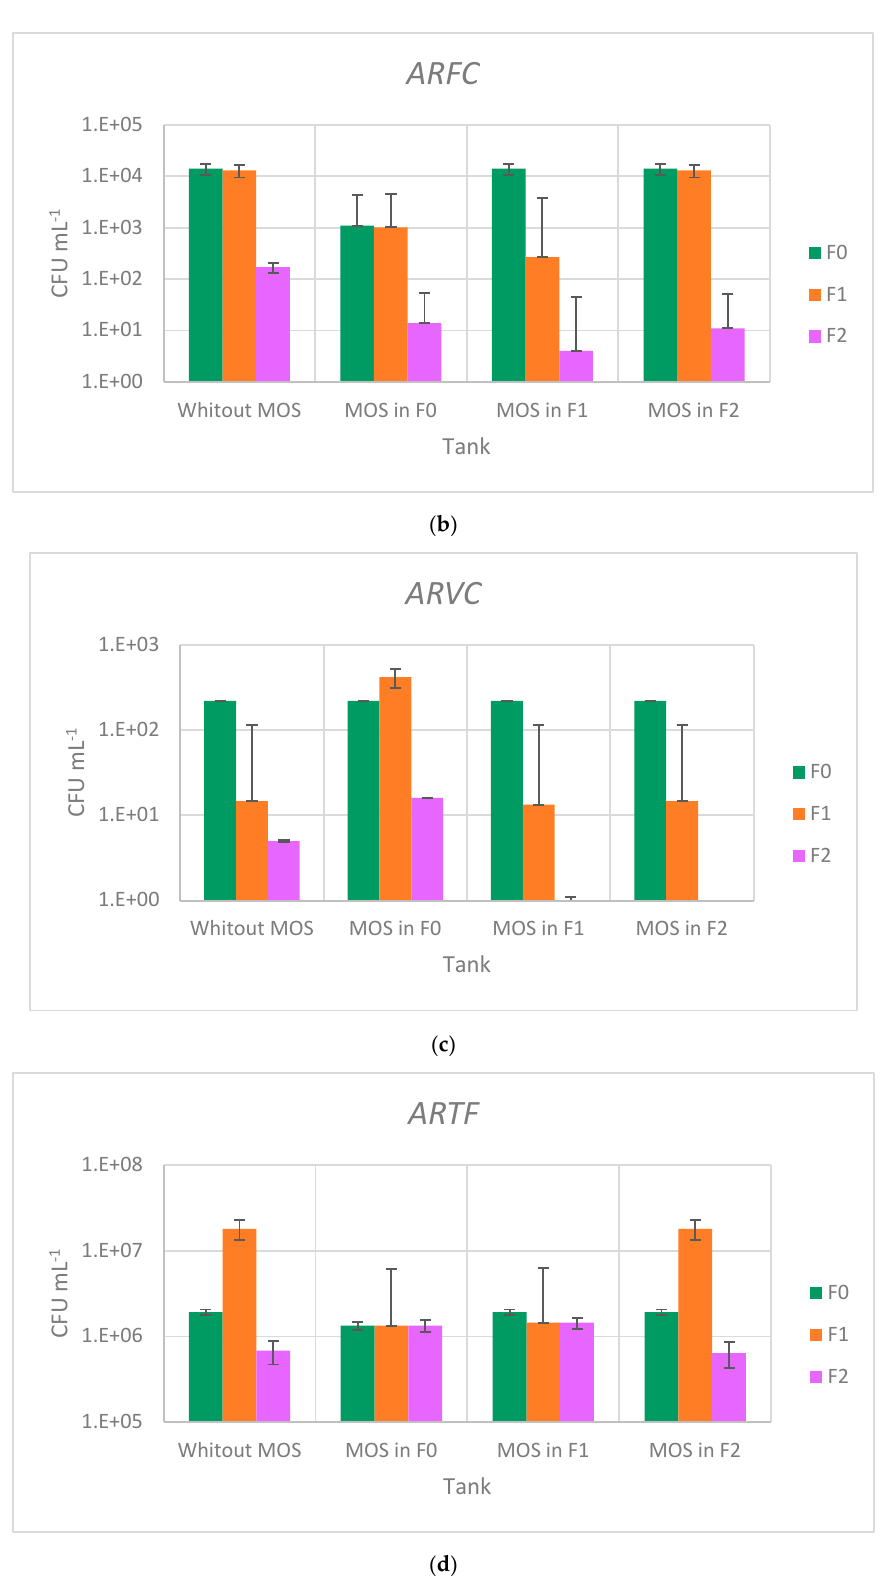
Figure 5. Projection of Moringa oleifera seeds’ (MOs) effect on the entire treatment plant prototype after MOs’ addition in F0, F1, F2; ( a ): abundance of antibiotic-resistant E. coli (AREC); ( b ): abundance of antibiotic-resistant faecal coliform (ARFC); ( c ): abundance of antibiotic-resistant Vibrio cholera (ARVC); ( d ): abundance of antibiotic-resistant total heterotrophic flora (ARTF).